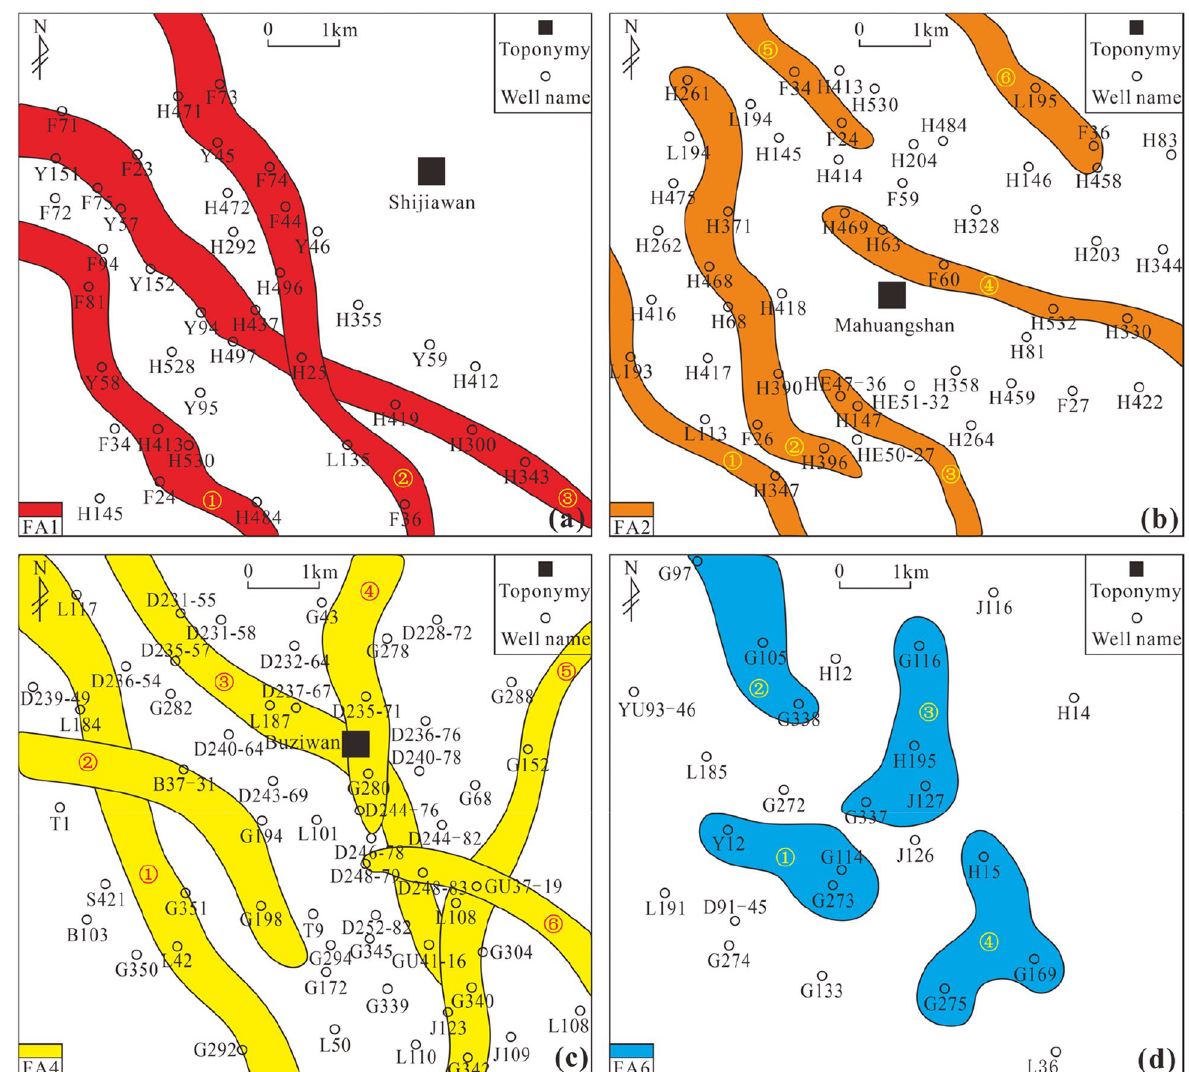
Figure 16. The local horizontal distribution of skeletal architectural